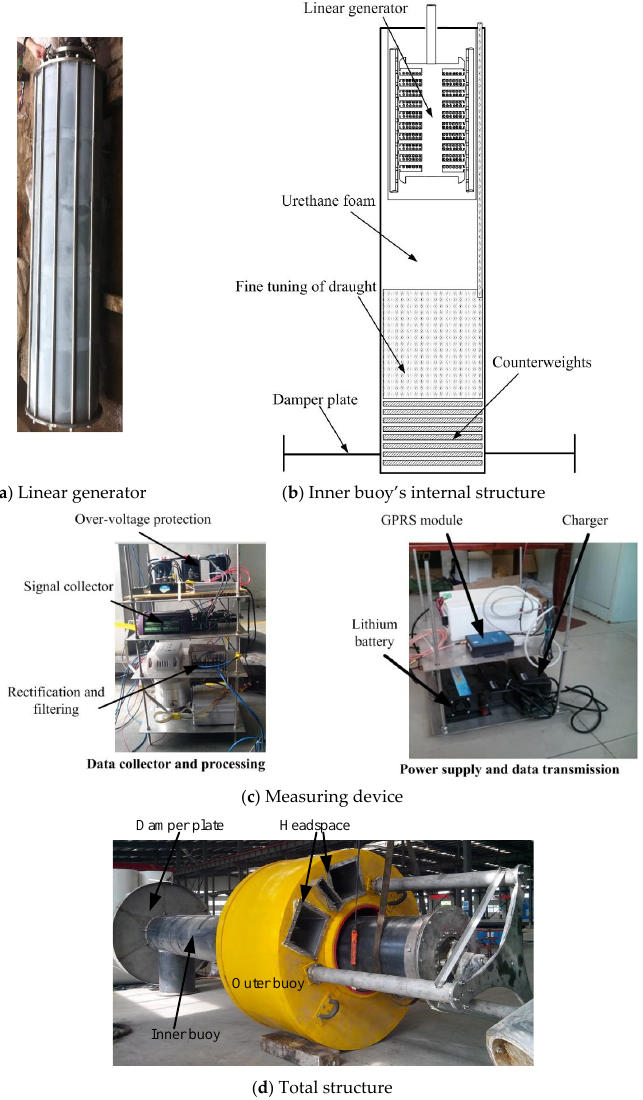
Figure 5. The specific structure of the double-buoy OWECS.